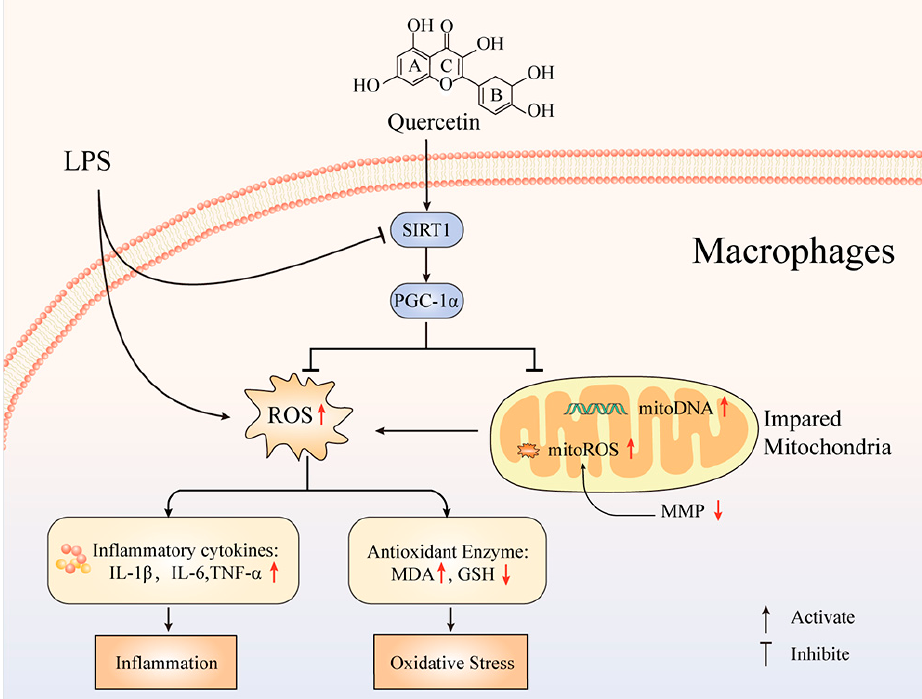
Figure 5. The process of quercetin mitigating LPS-induced oxidative damage in inflammatory macrophages. The upward red arrow indicates positive regulation, while the downward red arrow indicates negative